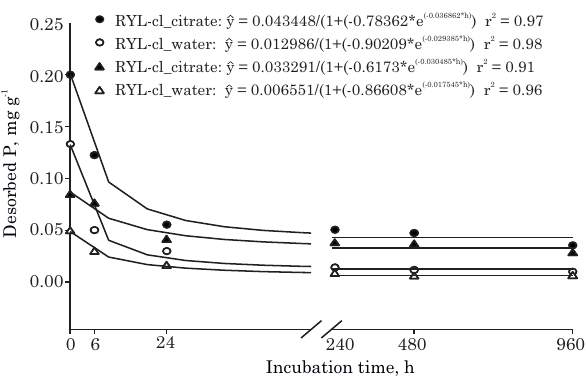
Figure 2. Concentration of desorbed P during 62 min of reaction, in clayey (RYL-cl) and sandy-loam texture Oxisol (RYL-sl), with citrate and water, in incubation periods of 0, 6, 24, 240, 480, and 960 h. * significant at 1 % by the F